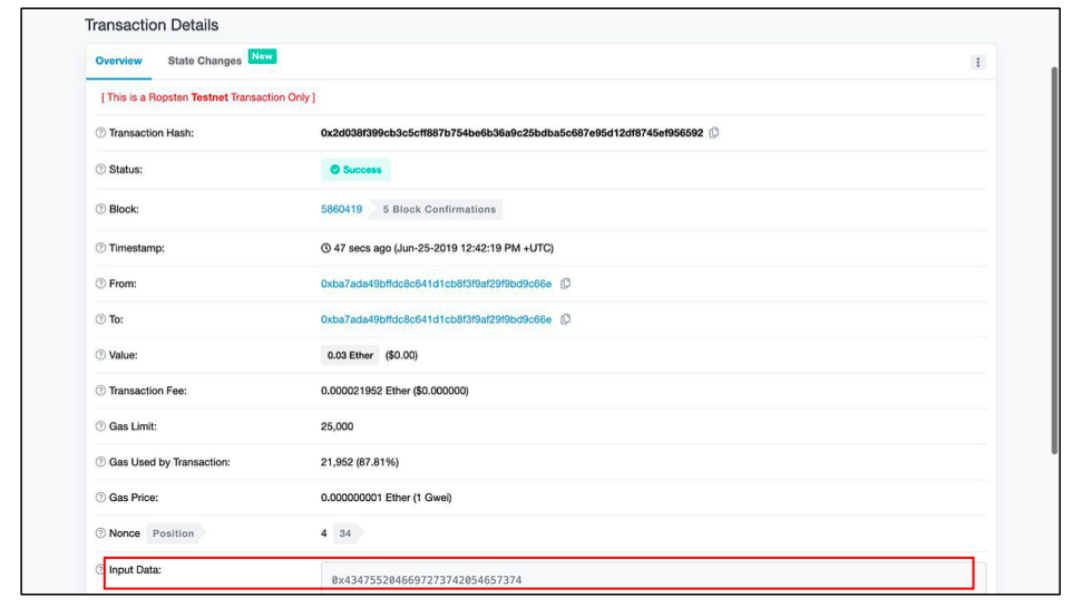
Figure 5. This is a figure. Figure 18. Data stored in a public